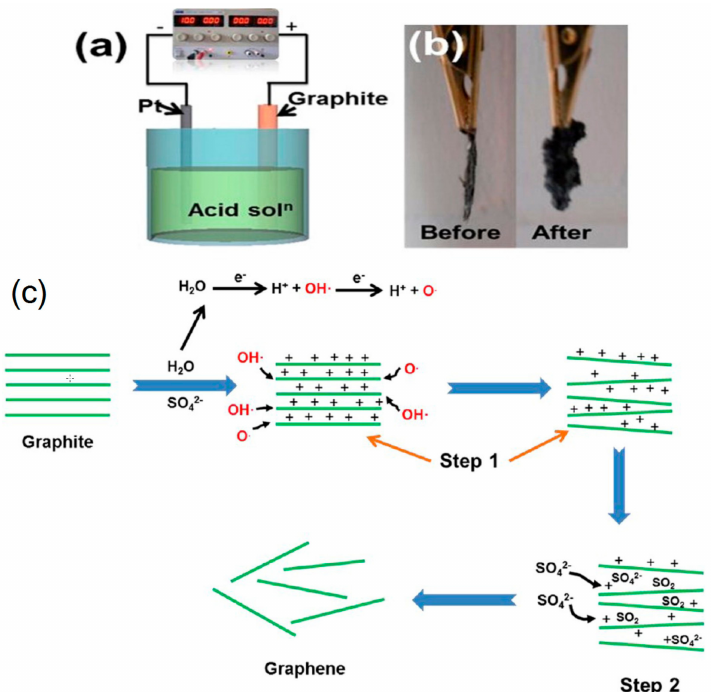
Figure 3. Electrochemical exfoliation for graphene production. ( a ) Electrochemical exfoliation; ( b ) Samples before and after exfoliation; ( c ) Structures of graphene before and after electrochemical exfoliation. Reproduced with permission from [63]. Copyright 2013, American Chemical